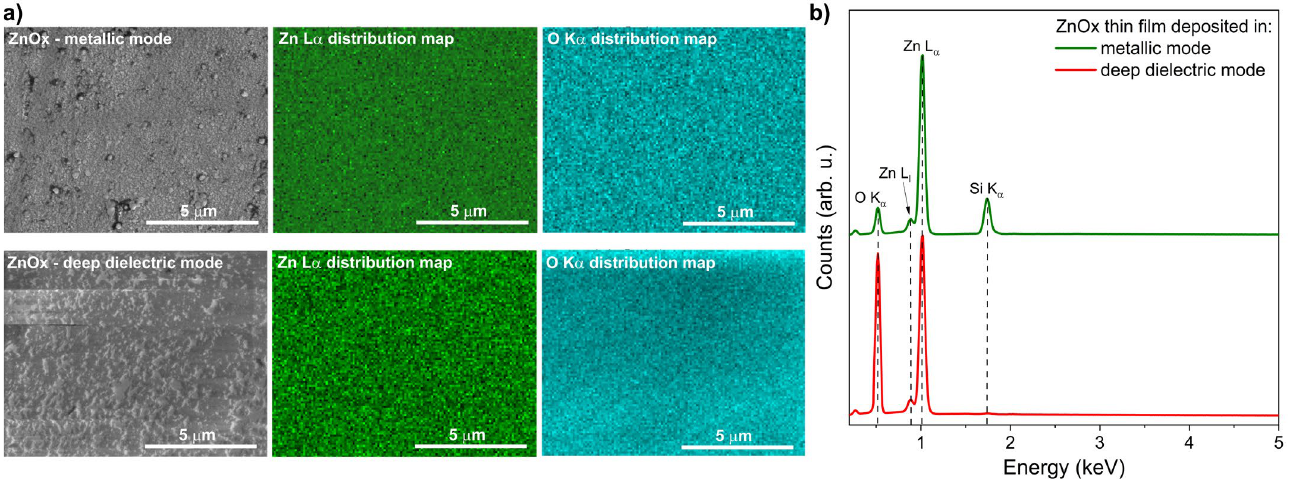
Figure 7. Results of material composition investigation: ( a ) elemental distribution maps and ( b ) EDS spectra of ZnOx thin films deposited in metallic and deep dielectric modes.